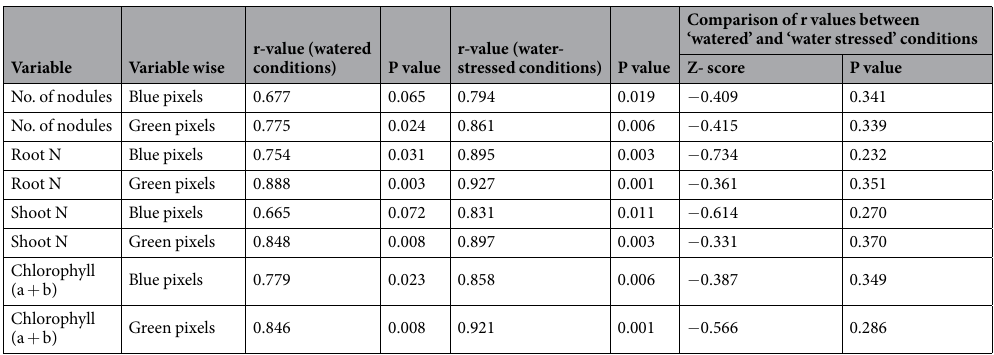
Table 4. Comparison of correlation co-efficient (r-values) based on correlation analysis of variables from destructive (direct quantification) and non-destructive (RGB analysis) assay methods in watered and stressed